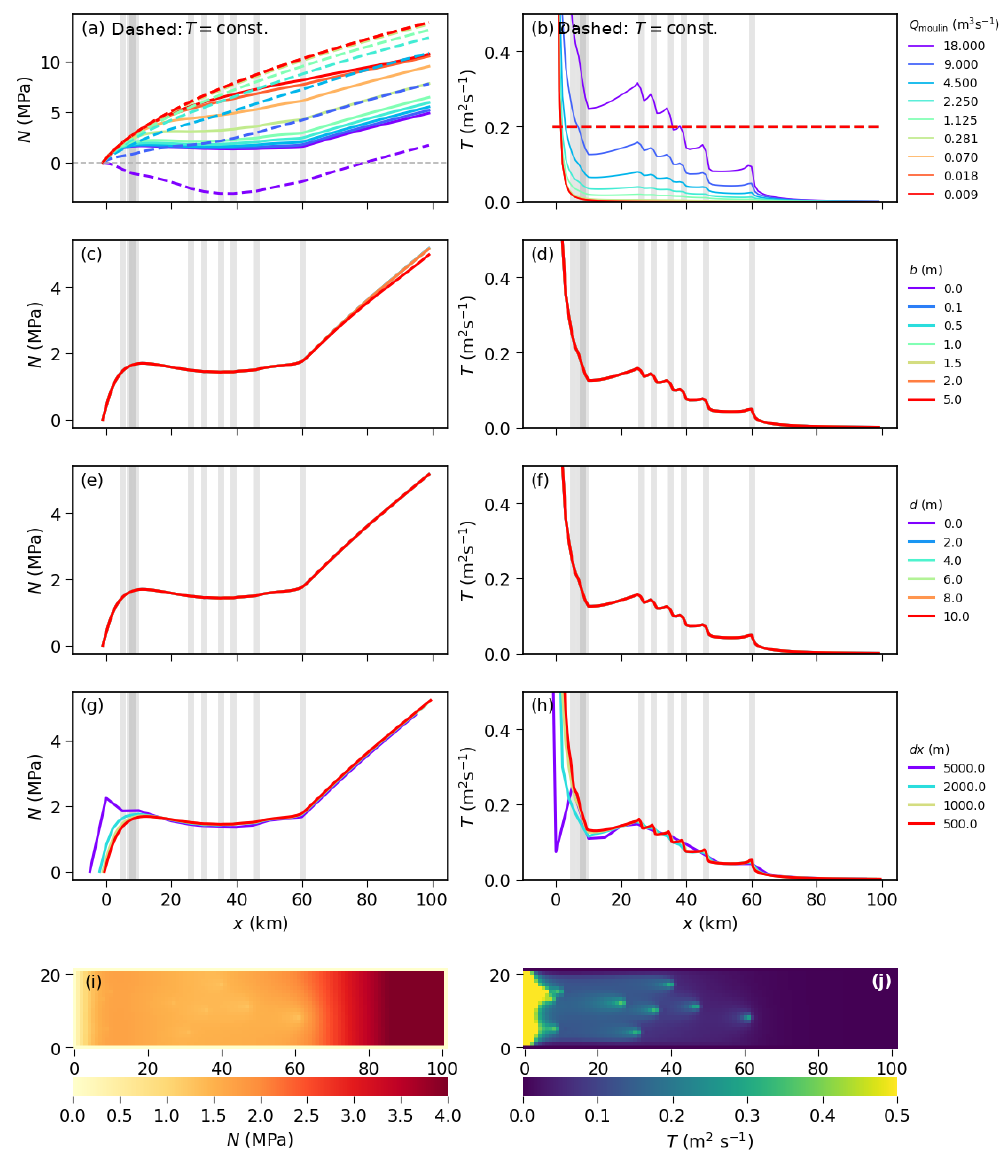
Figure 3. Results from the general sensitivity experiments showing the dependence of N (left) and T (right) on (a–b) the water supply from moulins Q moulin (results for deactivated transmissivity evolution are shown by dashed lines), (c–d) the aquifer layer thickness b , (e–f) the confined–unconfined transition parameter d , and (g–h) the grid resolution d x . Values shown are averaged along the y axis to represent cross- sections at flow lines. Transmissivity plots are cut off at 0.5m 2 s − 1 to improve visibility of the relevant range. Panels (i) and (j) show the two-dimensional distributions (map view) of the results using the best-fit baseline